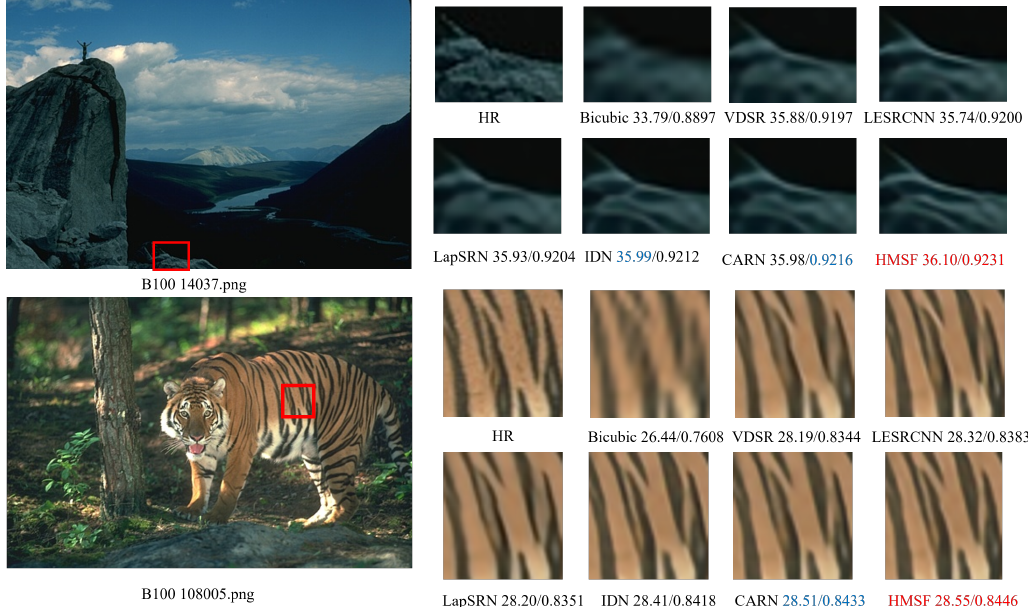
Figure 11. Visual qualitative comparisons on 3 × scale